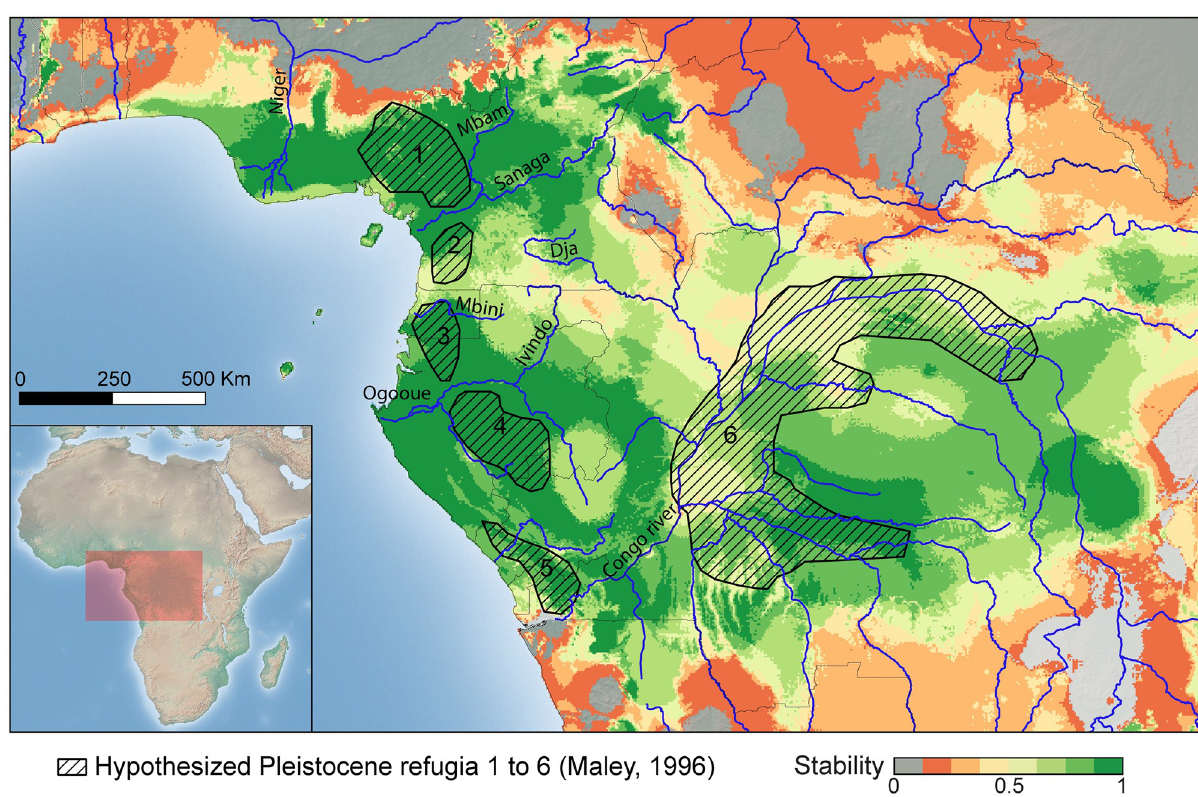
Fig 8. Stability map representing regions of persistent suitable habitat for Rhampholeon spectrum species complex across LGM and current climate regimes. The green color represents the highest habitat stability inferred. 1: Cameroon Volcanic Line; 2: Ngovayang and surrounding massifs; 3: Monts de Cristal; 4: Monts Doudou; 5: Massif du Chaillu; and 6: Congo River.